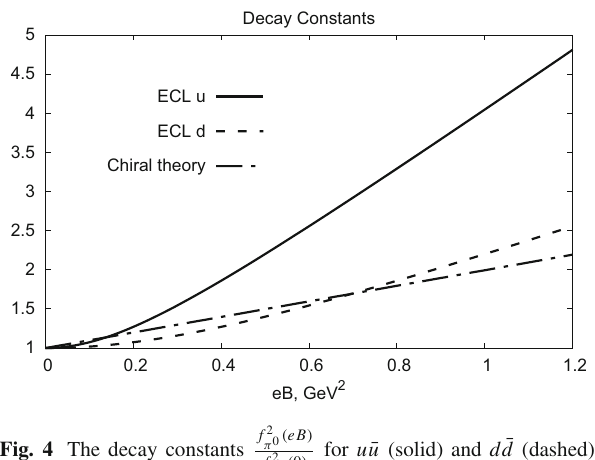
m 2 π 0 ( eB ) with u ¯ u quark constituents cal- e 2 π 0 ( 0 )